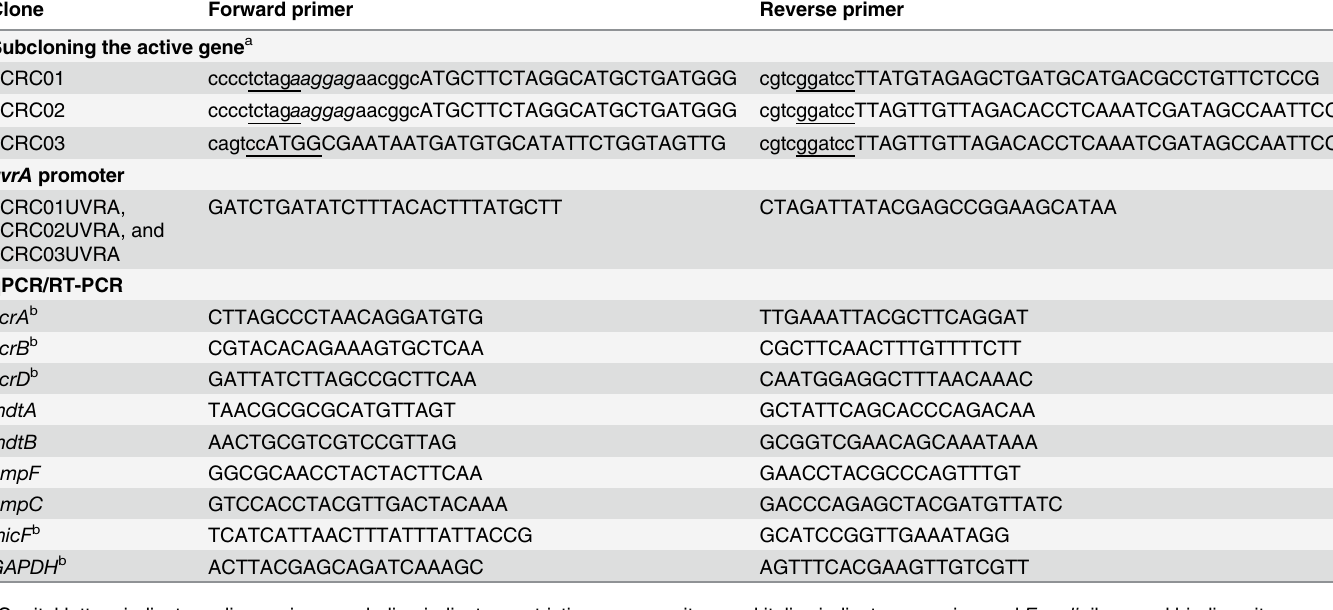
a Capital letters indicate coding regions, underline indicates restriction enzyme sites, and italics indicate an engineered E . coli ribosomal binding site. b Primers are from Viveiros et al. 2007